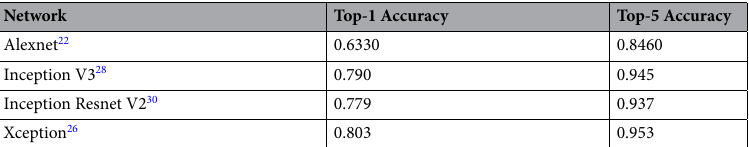
Table 1. The Inception V3, Inception Resnet V2, and Xception architectures pre-trained and bench-marked on the ImageNet dataset to illustrate each architectures performance on a generalised dataset and to justify the selection of architectures in the study.